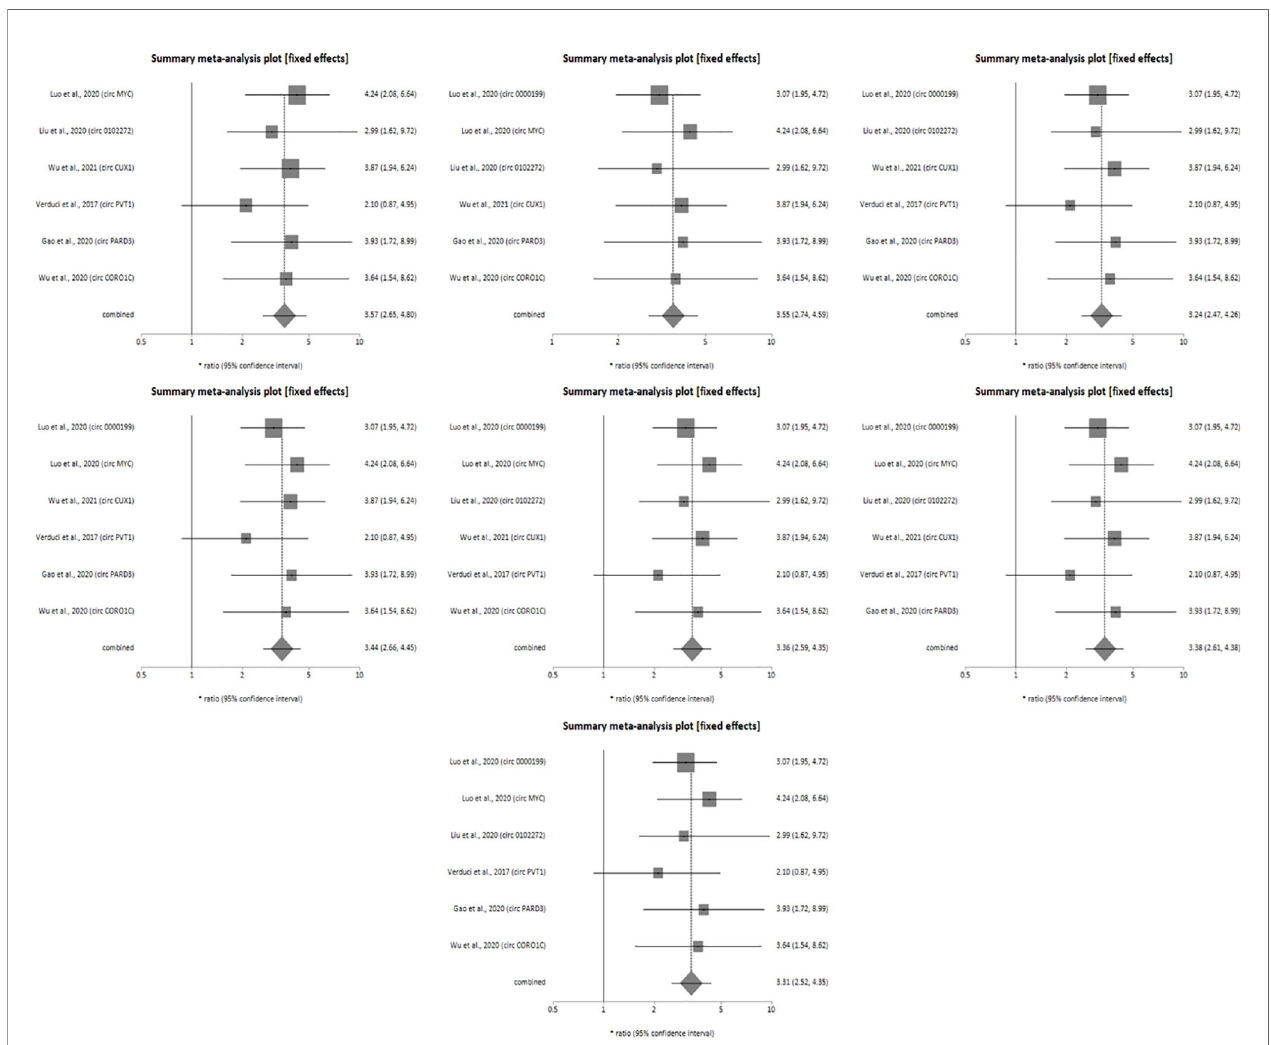
FIGURE 4 | Forest plots of sensitivity analysis showing the combined HR values at 95% CI upon sequential deletion of the studies included in univariate analysis which reported upregulated circRNAs. Square shapes indicate the effect size of each upregulated circRNA pro fi le, while diamond shapes indicate the overall effect size. The 95% CI of each effect sizes are indicated by respective